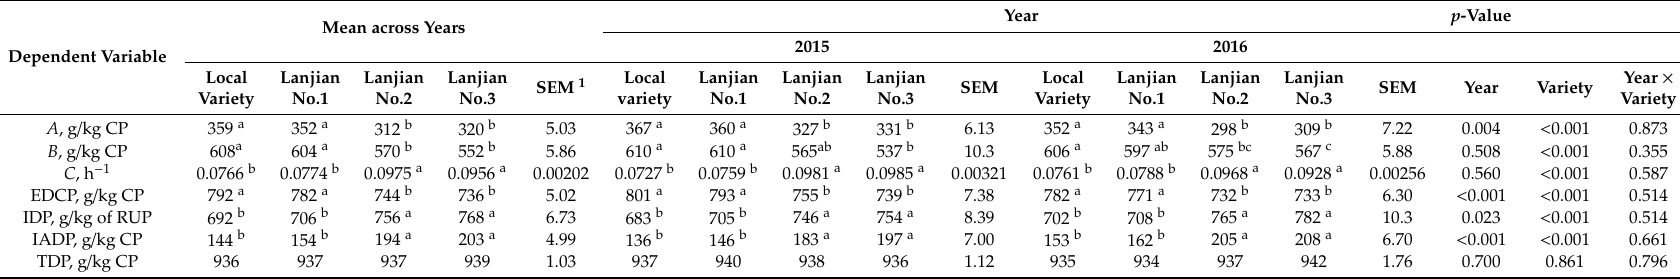
Table 4. E ff ects of cropping year, variety, and the year × variety interaction on the ruminal degradation kinetics of crude protein and intestinal protein digestibility of four common vetch varieties grown on the Tibetan